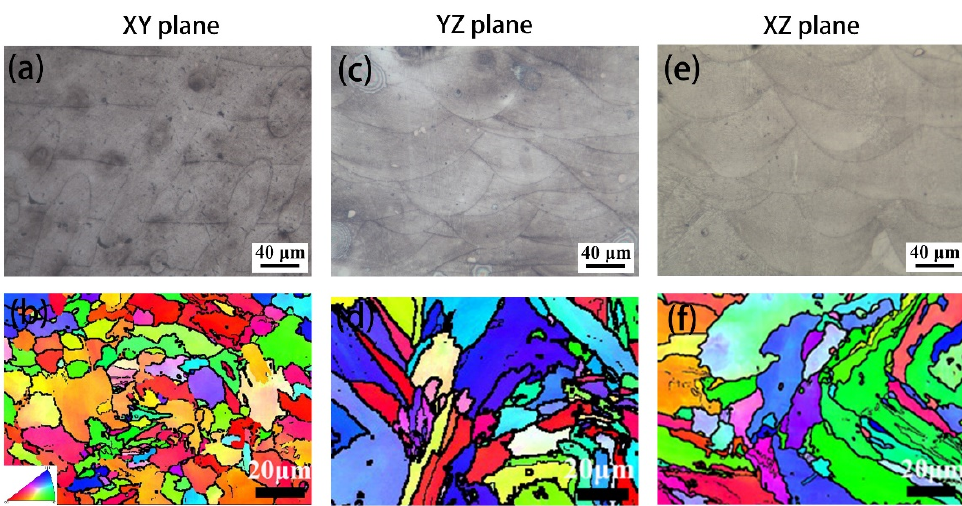
Figure 2. The OM and EBSD microstructures for different planes of the as ‐ printed nickel ‐ based superalloy specimen: ( a ) OM and ( b ) EBSD of XY plane, ( c ) OM and ( d ) EBSD of YZ plane, and ( e ) OM and ( f ) EBSD of XZ plane.